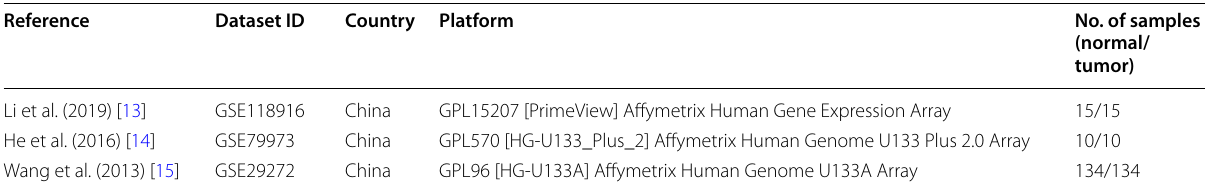
Table 1 Information for GEO gastric cancer data